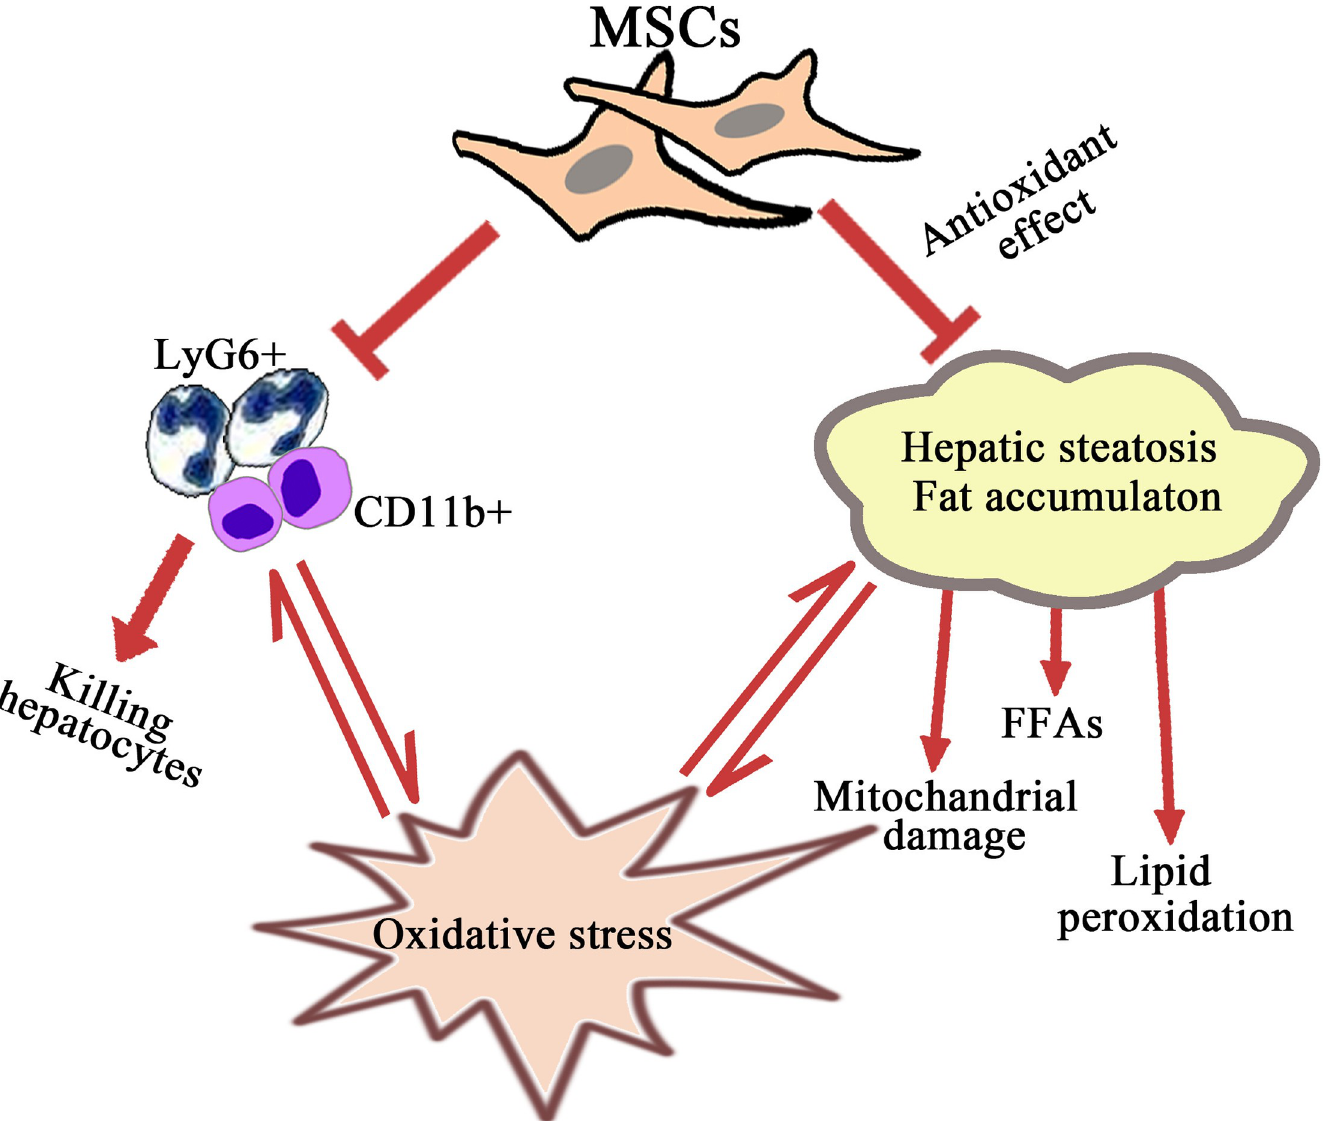
Fig 8. Schematic mechanism of mouse BM-MSCs activities in the treatment of alcoholic hepatitis. BM-MSCs, bone marrow-mesenchymal stem cells.